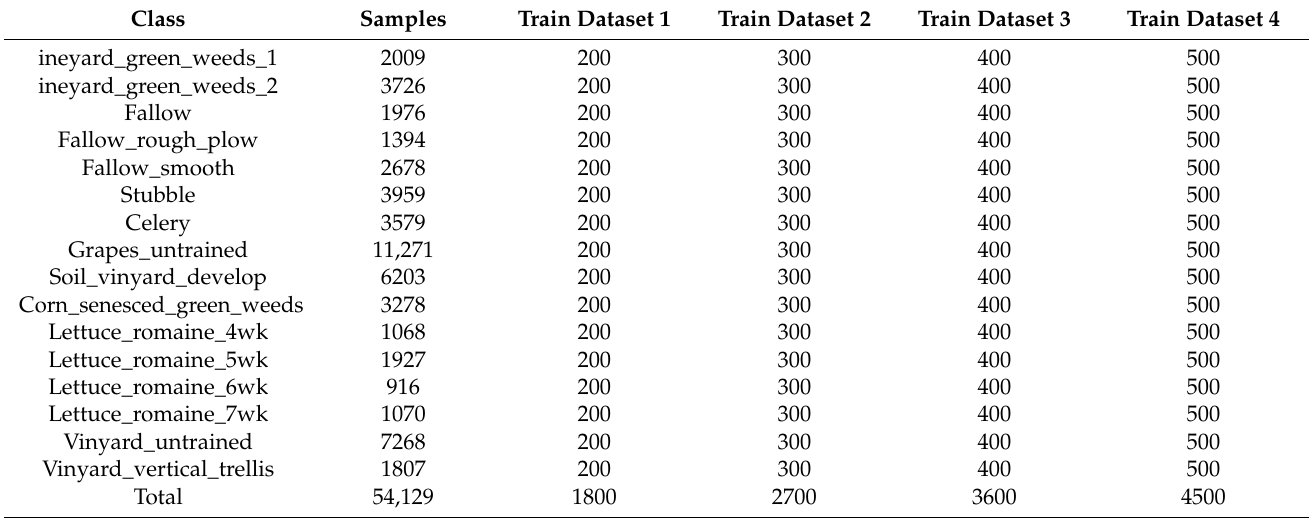
Table 7. Ground truth classes for the Salinas scene and their respective numbers of